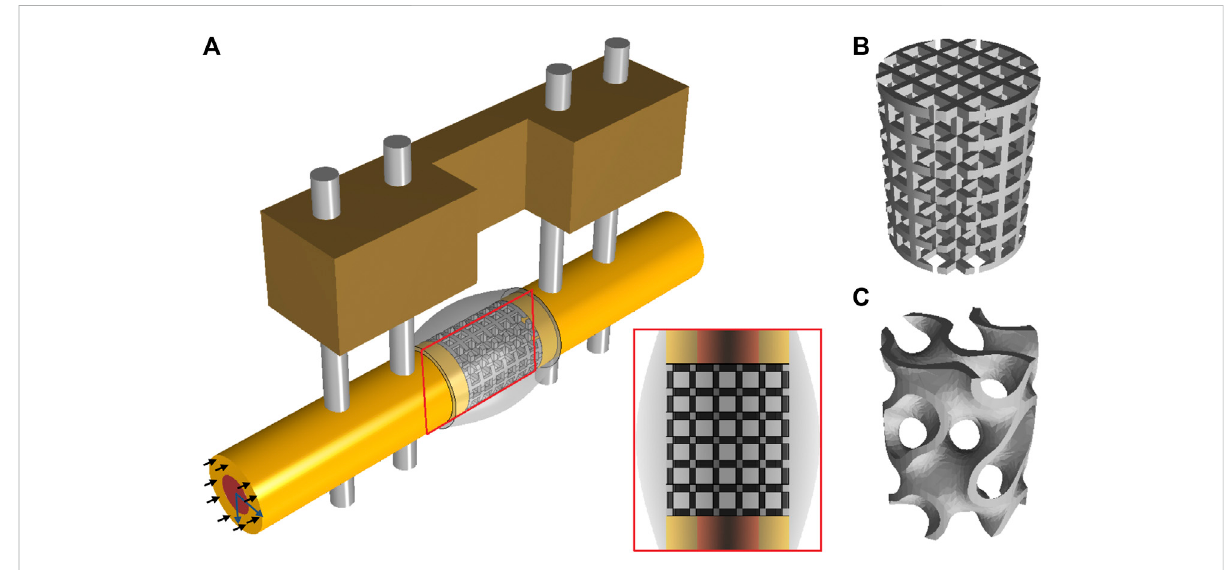
FIGURE 1 (A) CAD model simulating a large bone defect in the rat femur stabilized with an external fi xator. In the defect a strut-like (B) or a gyroid (C) scaffold was virtually inserted. The black arrows represent the compressive loads and the blue arrows represent the tangential loads inducing